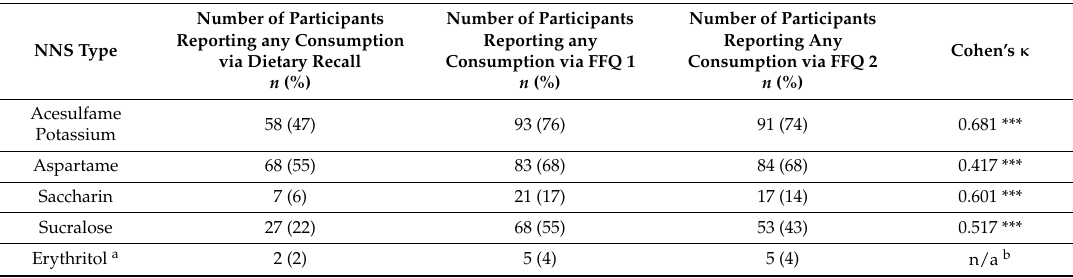
Table 2. Non-nutritive sweetener (NNS) consumption patterns among 123